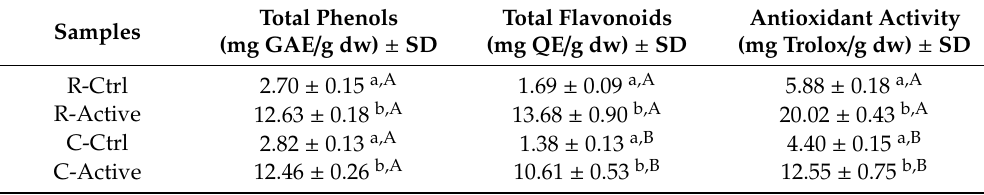
Table 1. Total phenols, total flavonoids, and antioxidant activity of raw and cooked sticks.